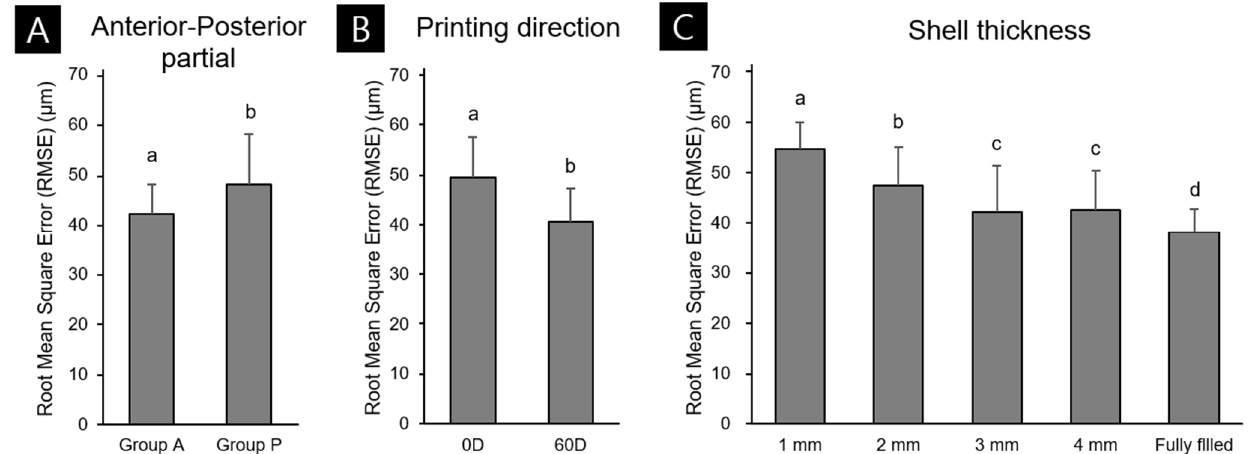
Figure 4. RMSE values from three-way ANOVAs for Groups A and P ( A ), printing direction ( B ), and ( C ) outer wall thickness. Lower-case letters indicate significant differences ( p < 0.05). Data are mean and standard deviation values.